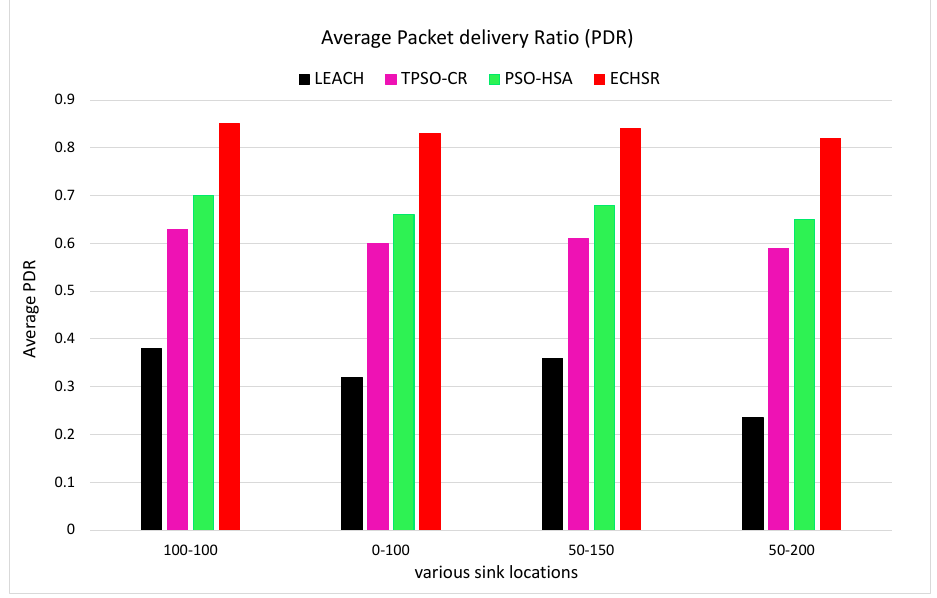
Figure 14. The average residual energy without forest fire scenarios for various sink locations.